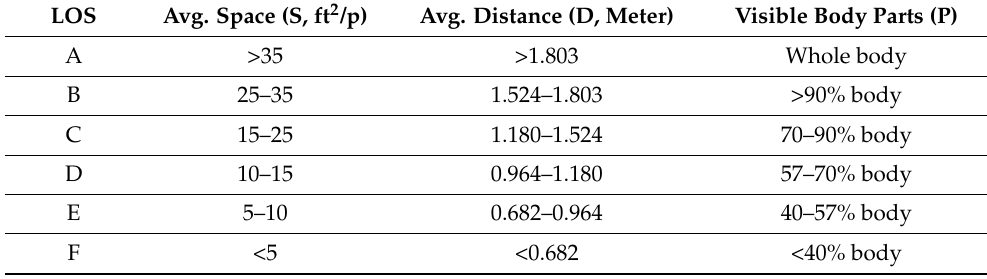
Table 1. The relationship between the LOS and the percentage of visible body parts.